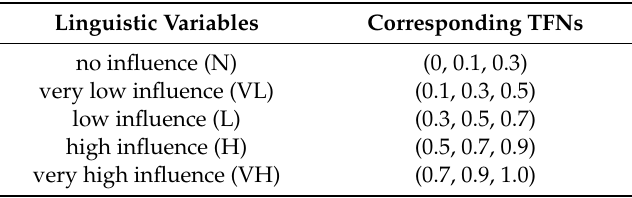
Table 2. Fuzzy ratings for the linguistic